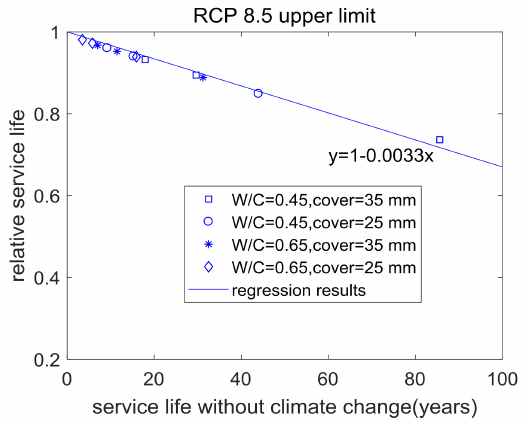
Figure 17. Relative service life of cracked concrete-RCP 8.5 upper 90% confidence interval, time slice 2000.